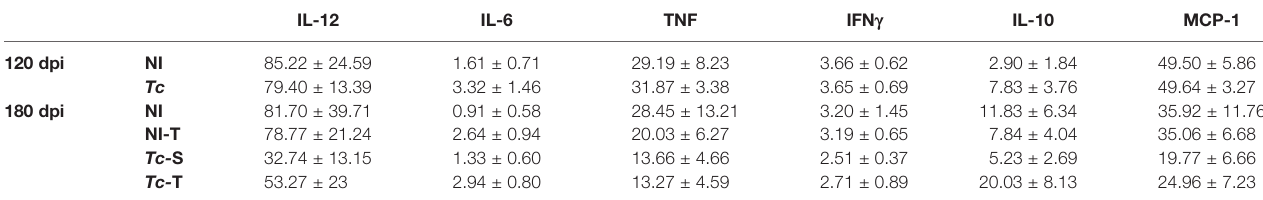
TABLE 1 | Cytokine concentrations in plasma of Trypanosoma cruzi -infected C57BL/6. IL-12 IL-6